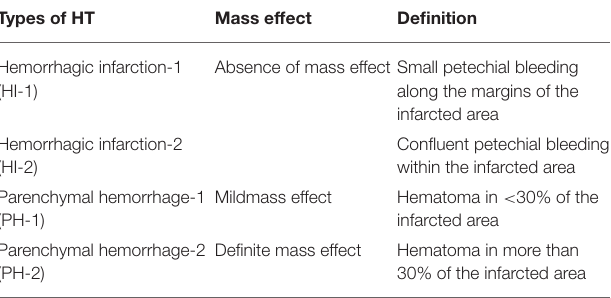
TABLE 1 | Characteristics of hemorrhagic transformation (HT) according to European Cooperative Acute Stroke Study (ECASS) 2 (8). Types of